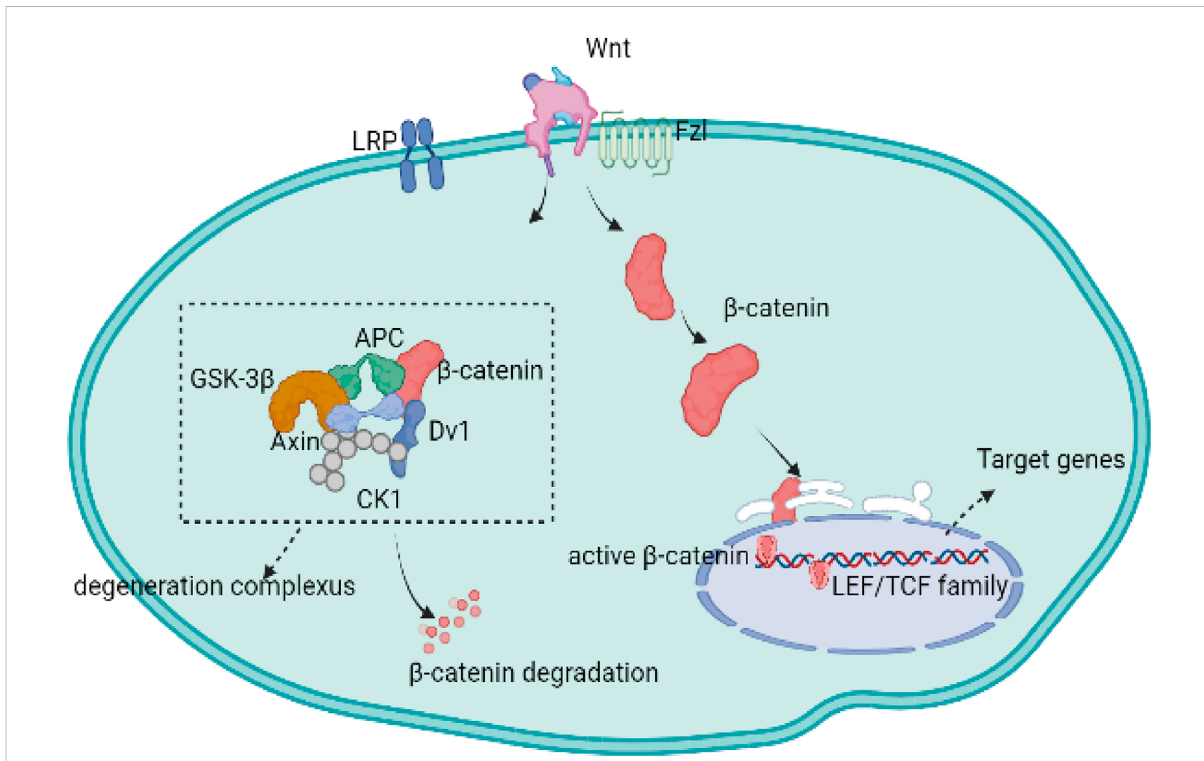
FIGURE 1 The canonical Wnt signaling pathway is dependent on the activation of intracellular molecule β -catenin. In the absence of Wnt-binding Fz receptors, β -catenin is isolated into a protein, phosphorylated, and subsequently degraded by the destruction complex. Upon binding to the Fzl receptors and LRP5/6 co-receptors, the Wnt/ β -catenin signaling pathways is activated while the degradation complex of β -catenin is inhibited, allowing the newly synthesized β -catenin to accumulate in the cytoplasm and transfer to the nucleus. Nuclear β -catenin can replace the transcription corepressors in TCF transcription factors and promote the activation of gene transcription